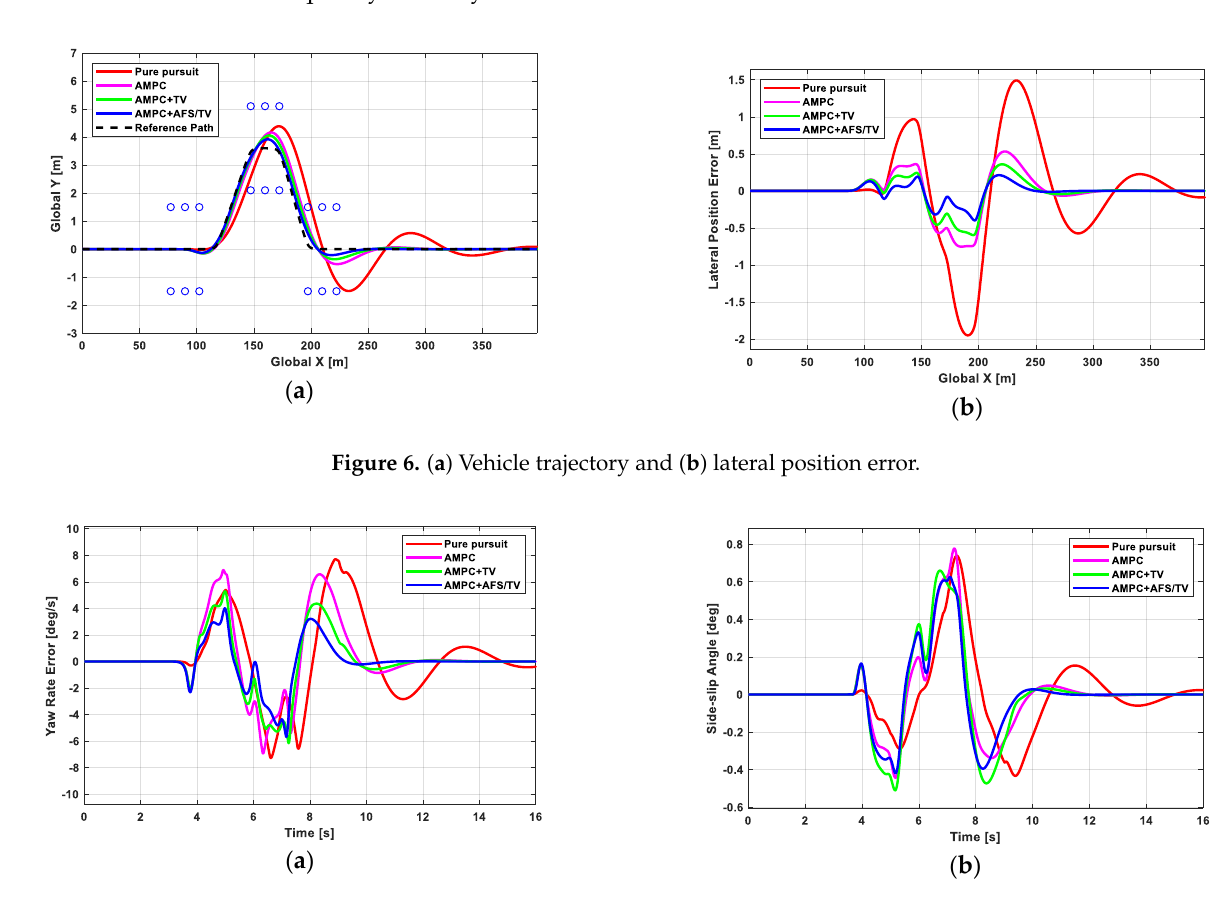
Figure 7. ( a ) Yaw rate error and ( b ) side-slip angle.